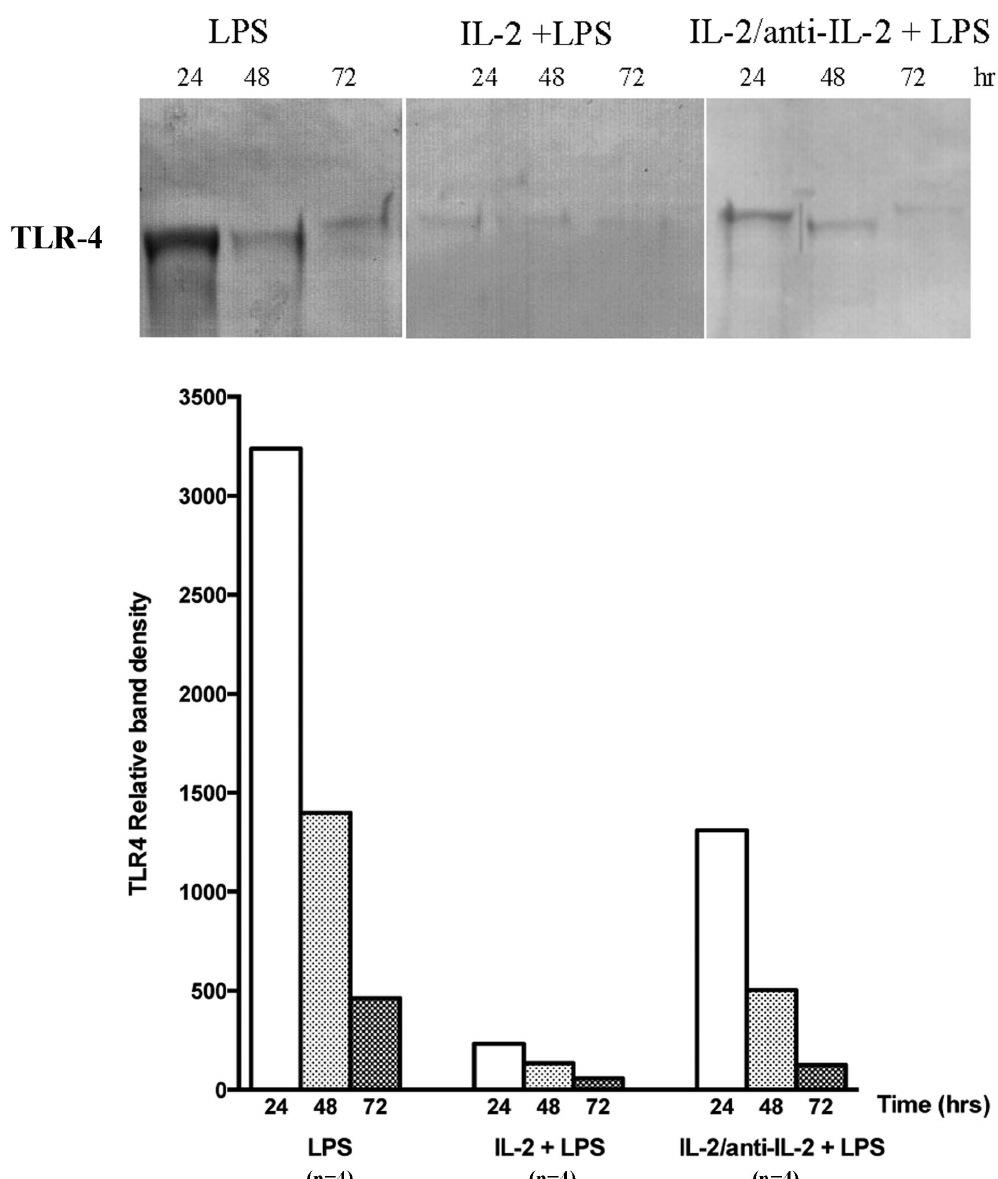
Figure 4. TLR-4 urine levels. Urine deriving from the same mice of the above experiments were utilized for determining levels of TLR-4, a molecule that interacts with LPS [10]. After LPS infusion, urine TLR-4 increased dramatically and then decreased in the following 72 hours. In mice treated with the combination of IL2 and LPS, urine TLR-4 levels were reduced by 1200% compared to LPS alone and then normalized in the 72 hours after. IL-2/ anti-IL-2 produced intermediate